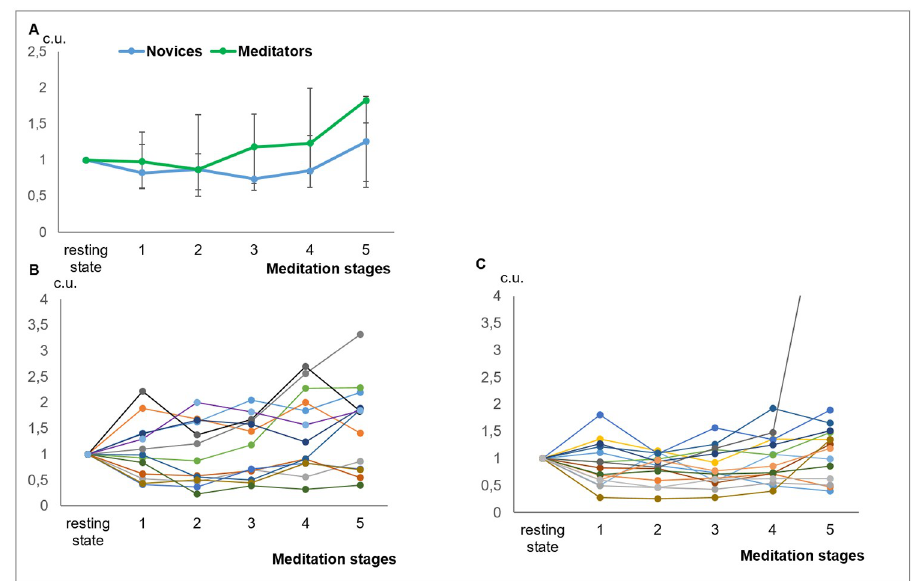
Fig 5. The index of relaxation (CV � prefrontal alpha to theta ratio) during meditation. (A) in the Experienced meditators and Novices. AN-test revealed a significant difference of curves (p = 0.028). Data presented as Median ± IQR; (B), (C)–in individual Experienced and Novice subjects respectively.